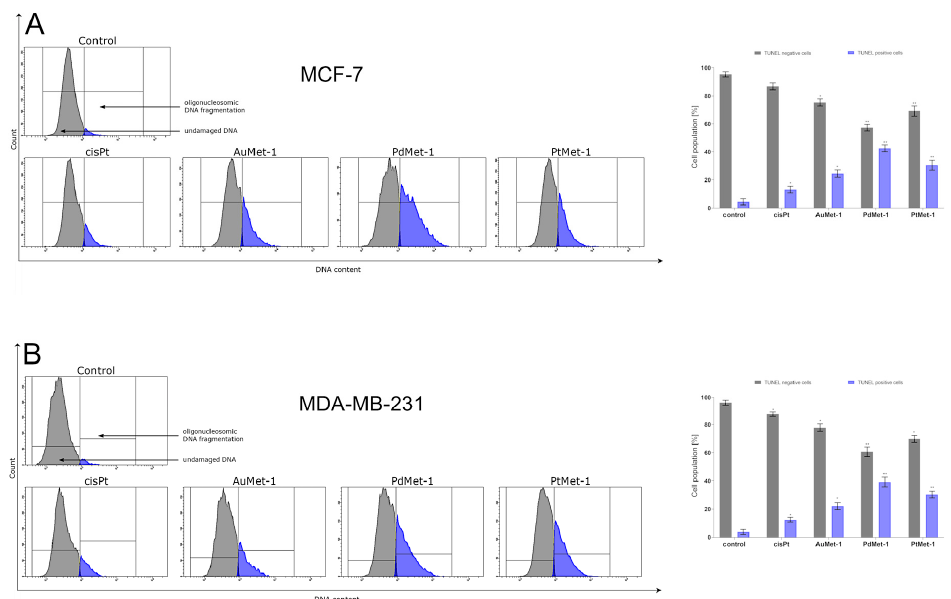
Figure 7. Flow cytometric analysis of DNA fragmentation of MCF-7 ( A ) and MDA-MB-231 ( B ) breast cancer cells after 24 h of incubation with AuMet-1, PdMet-1, PtMet-1 and cisplatin (50 µM) using TUNEL assay. Histograms present TUNEL negative and TUNEL positive cells. Mean percentage values from 3 independent experiments (n = 3) done in duplicate are presented. * p < 0.05 vs. control group, ** p < 0.01 vs. control group.